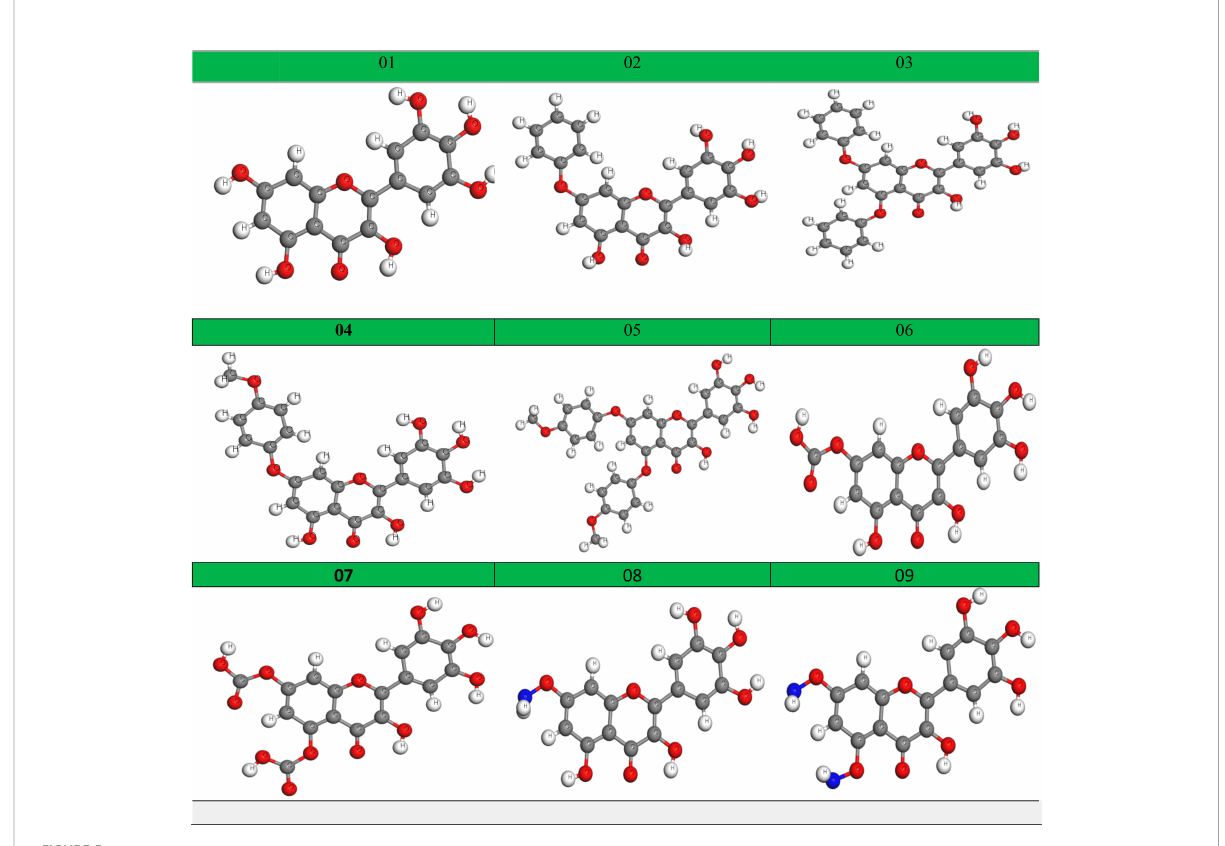
FIGURE 5 Optimized molecular structure.